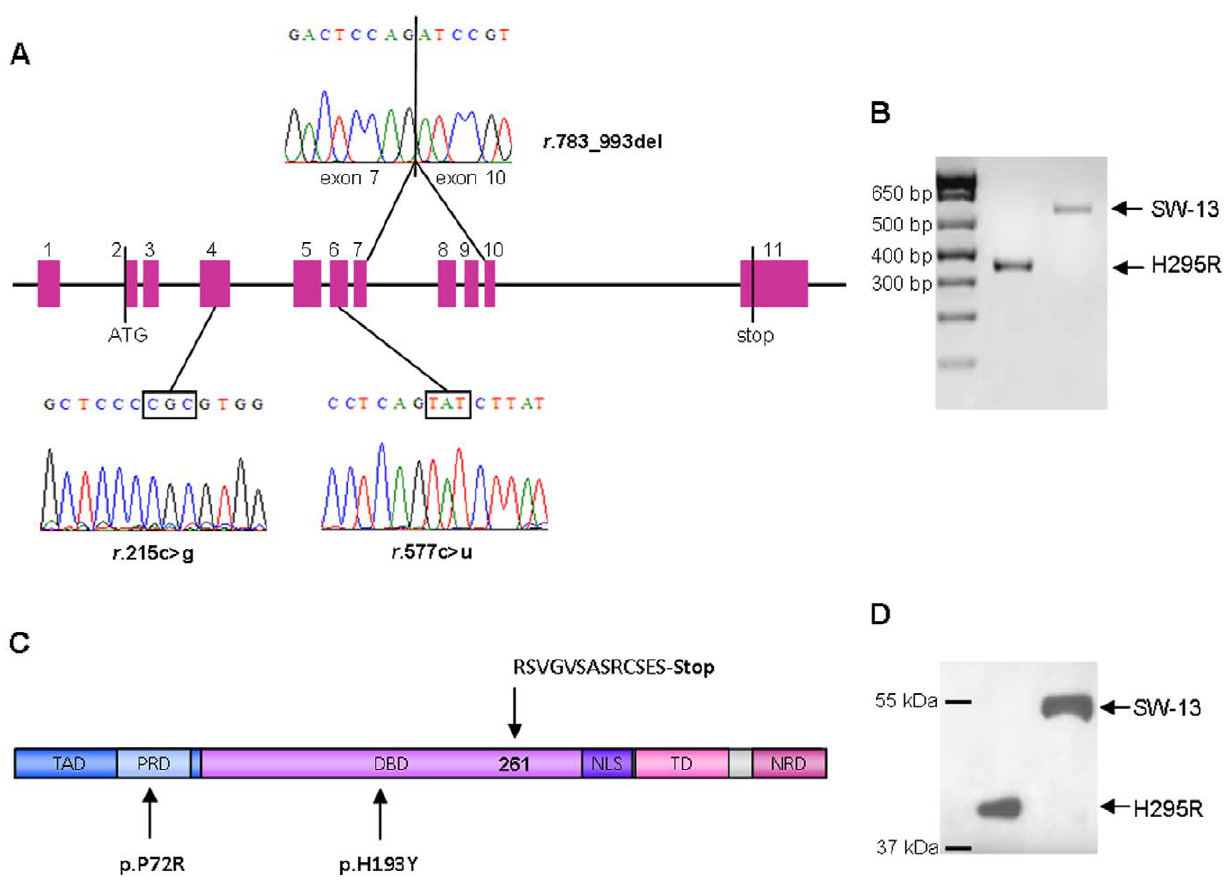
Figure 1. Sequencing analysis of TP53 coding sequence in H295R and SW-13 cell lines. (A) Representation of TP53 mutations identified in H295R and SW-13 cell lines, showing a large deletion affecting 211 base pairs in H295R cells (top) and a homozygous point mutation in exon 6 ( r.577c . u ) in SW-13 cell line (bottom). SW-13 cells also exhibit a polymorphic site located in exon 4 ( r.215c . g ). (B) Inverted image relative to RT-PCR analysis of exons 7 to 10 of TP53 gene. Electrophoresis on a 2% agarose gel revealed a major band of , 575 bp, corresponding to SW-13 transcript, and a minor band of , 364 bp, corresponding to H295R transcript (DNA ladder, 1 Kb plus). (C) Predicted amino-acid sequence of p53 in H295R and SW-13 cell lines. Deletion of exons 8 and 9 in H295R determines a frameshift starting at codon 261, creating a subsequent stop codon at position 274 (top). In SW-13 cells, a homozygous point mutation at codon 193 determines an amino-acid substitution (histidine to tyrosine) in the DBD of the protein (bottom). (D) Western blotting analysis of p53 in H295R and SW-13 cells, showing the presence of a shorter protein in H295R cell line, which molecular weight is , 44 kDa.